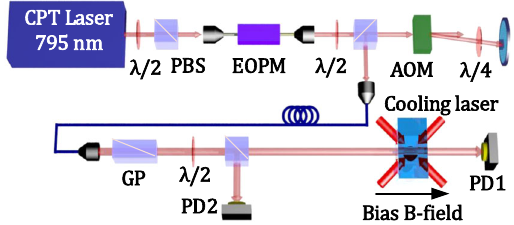
Fig. 6 Schematic diagram of our experimental apparatus. AOM: acousto-optic modulator, EOPM: electro-optic phase modulator, GP: Glan prism, PBS: polarization beam splitter, PD: